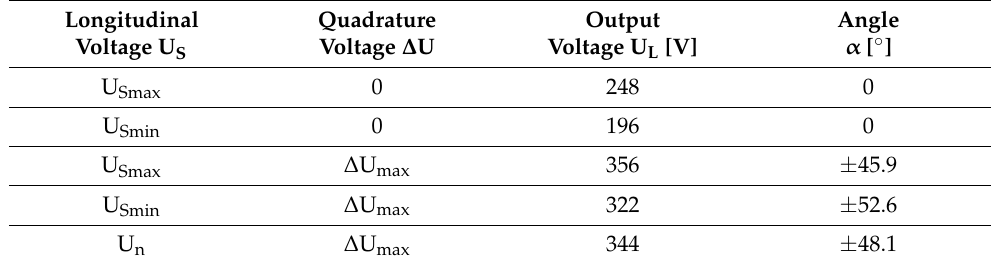
Table 2. Parameters of the output voltage and phase angle for chosen cases of ACPST settings. Longitudinal